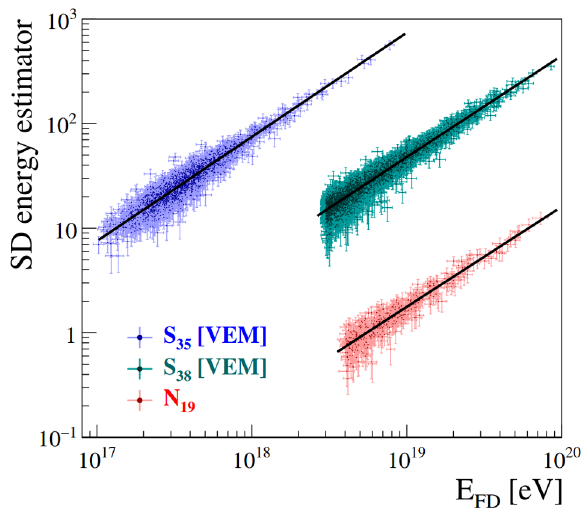
Figure 3. Calibration functions: correlation between the FD en- ergy and the SD energy estimator for the three SD data sets. The black lines represent the best fit for each data set. Figure taken from Ref.